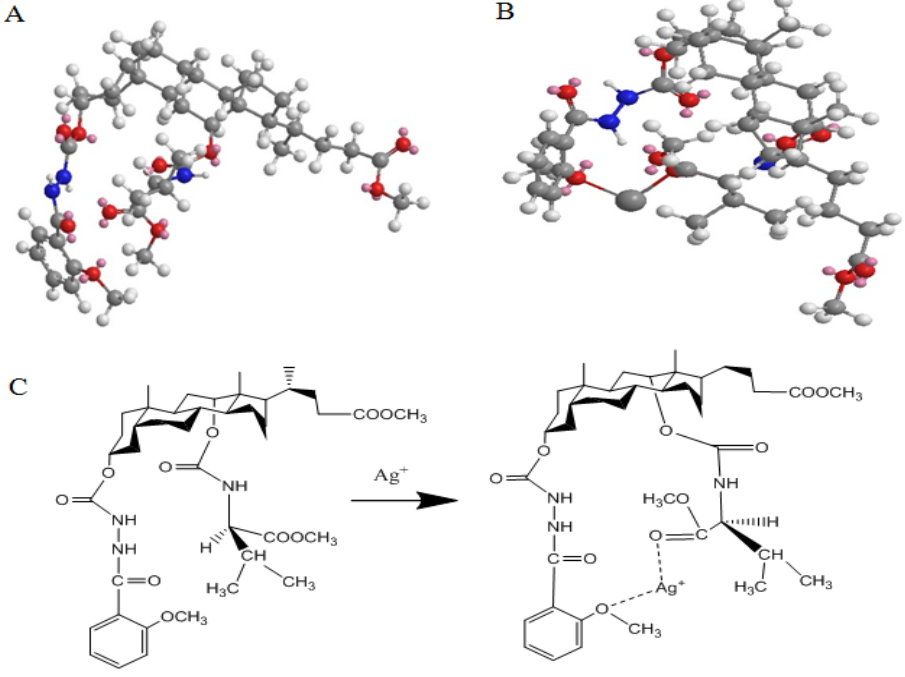
Figure 7. ( A ) The energy-minimized conformation of molecular tweezer 7a . ( B ) The energy-minimized conformation of complex compound 7a + Ag + . ( C ) Possible binding model of molecular tweezer 7a and Ag + .